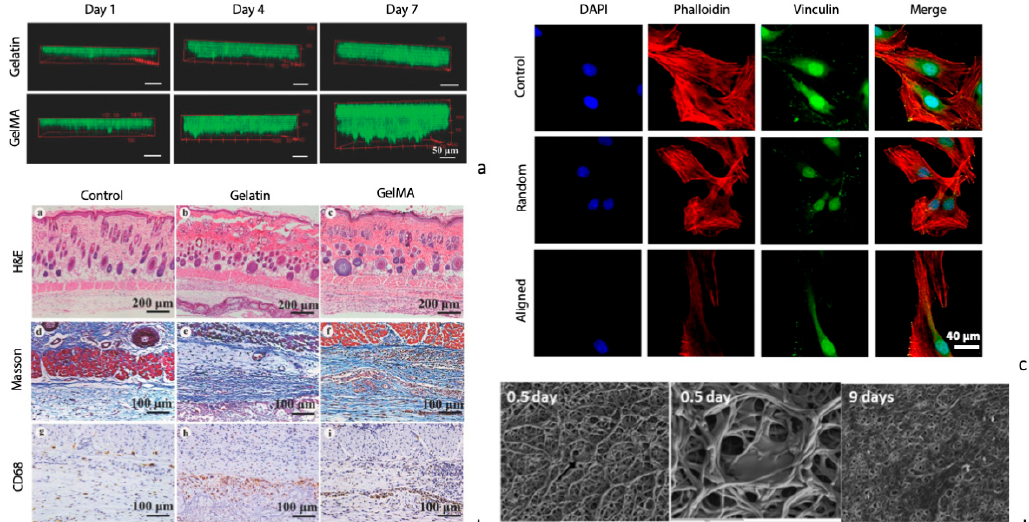
Figure 5. Tissue engineering applications of electrospun cross-linked gelatin matrices. ( a ) Cell infiltration inside electrospun gelatin vs. GelMA scaffolds (phalloidin staining, Alexa Fluor 488; scale bar: 50 μ m) and ( b ) in vivo assessment of electrospun gelatin and GelMA scaffold skin regenerative potential by histological analysis (scale bar: 200 and 100 μ m); reprinted from [100] with permission of Elsevier. ( c ) Confocal images of primary Schwann cells cultured on random and aligned electrospun gelatin matrices (vs. tissue culture plastic as control; scale bar: 40 μ m) [97]. ( d ) SEM micrographs of human umbilical vein smooth muscle cells cultured on electrospun gelatin matrices for smooth muscle regeneration in vascular tissue engineering; reprinted from [83] with permission of John Wiley